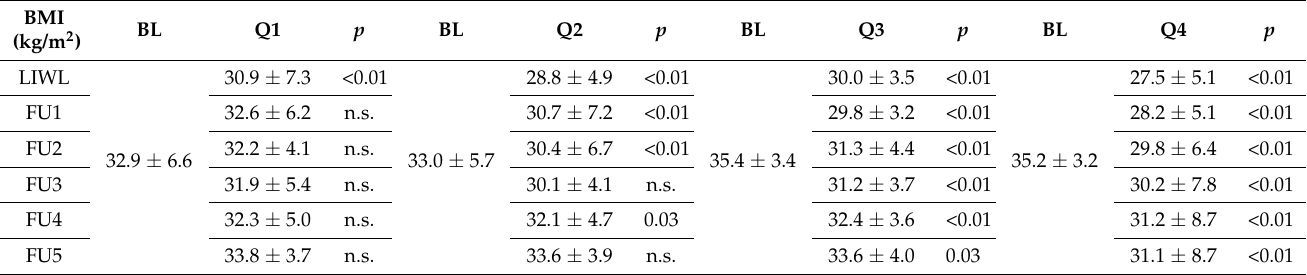
Table 2. Median and interquartile ranges of BMI before and after LIWL and during the 5-year follow-up.